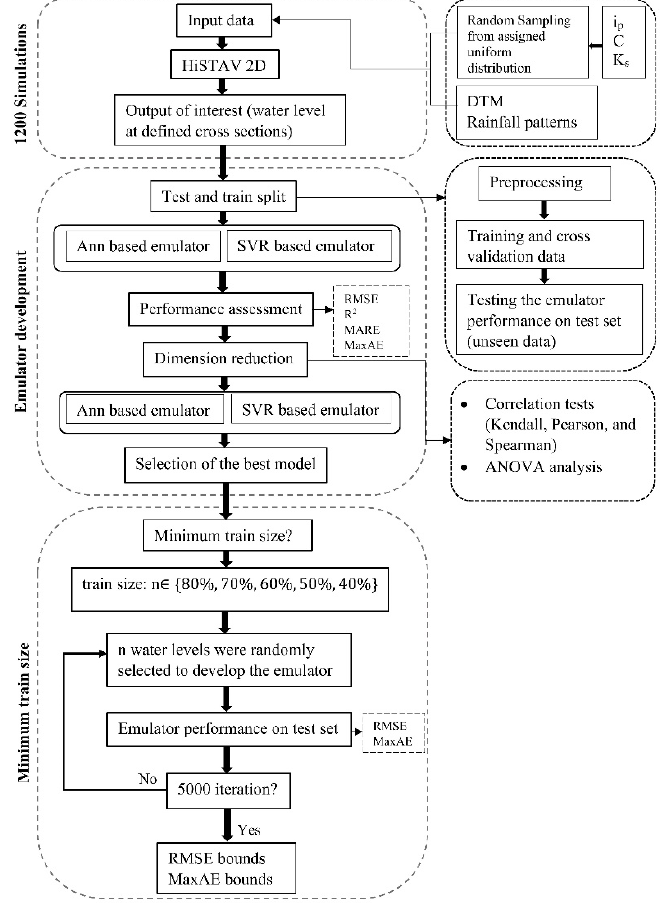
Figure 5. General overview of the methods.